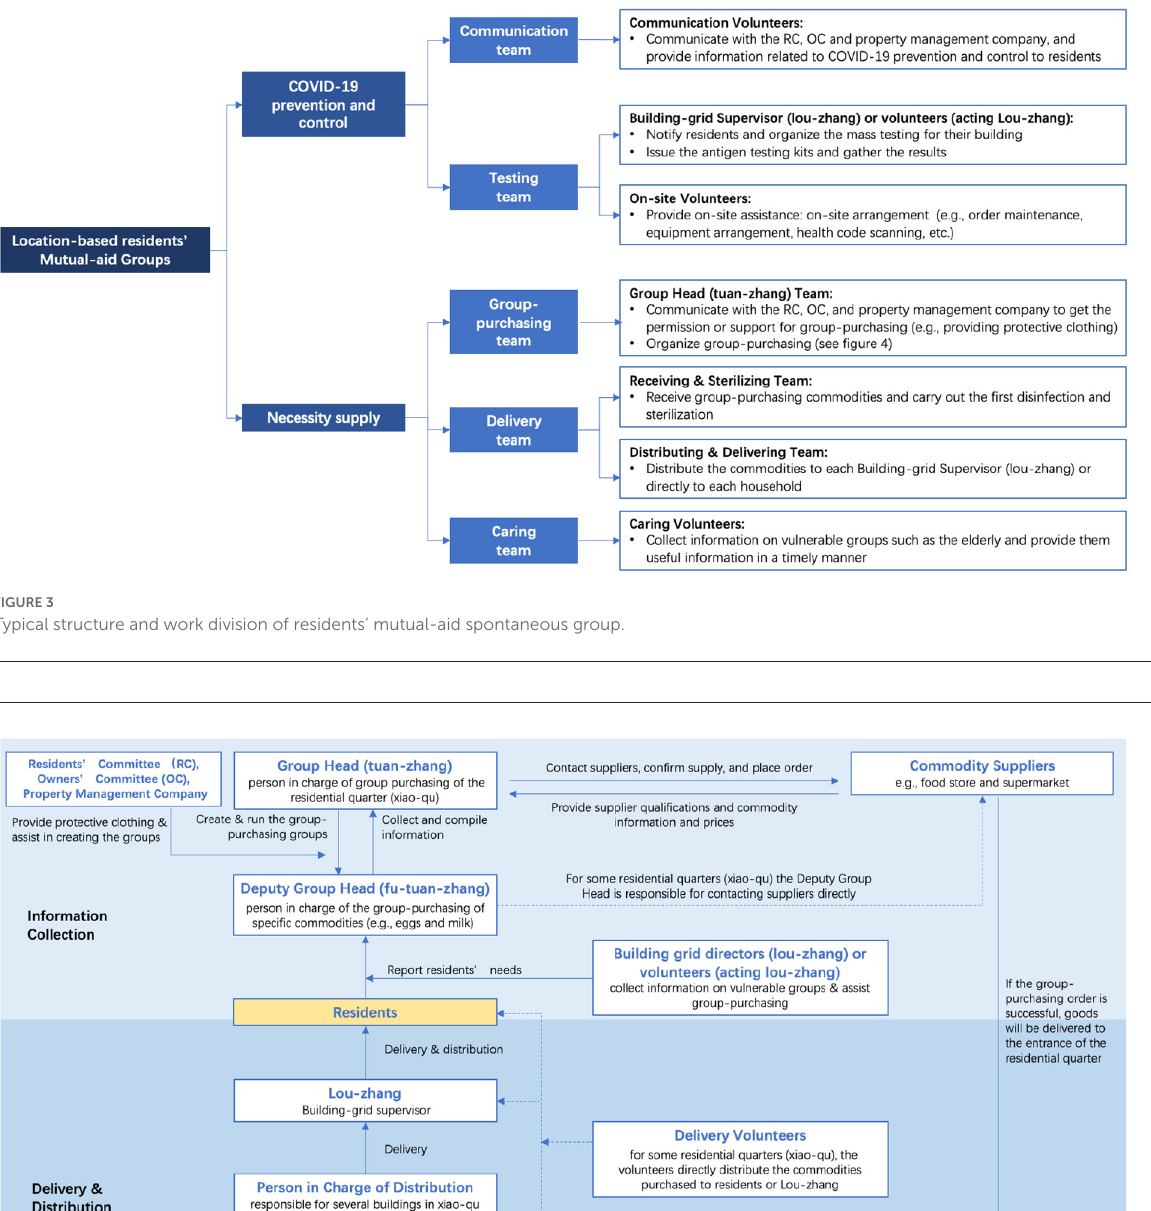
to quickly form their architecture based on the division of tasks and centered around tuan-zhang (the leader of the group-purchase activity) (as illustrated in Figure